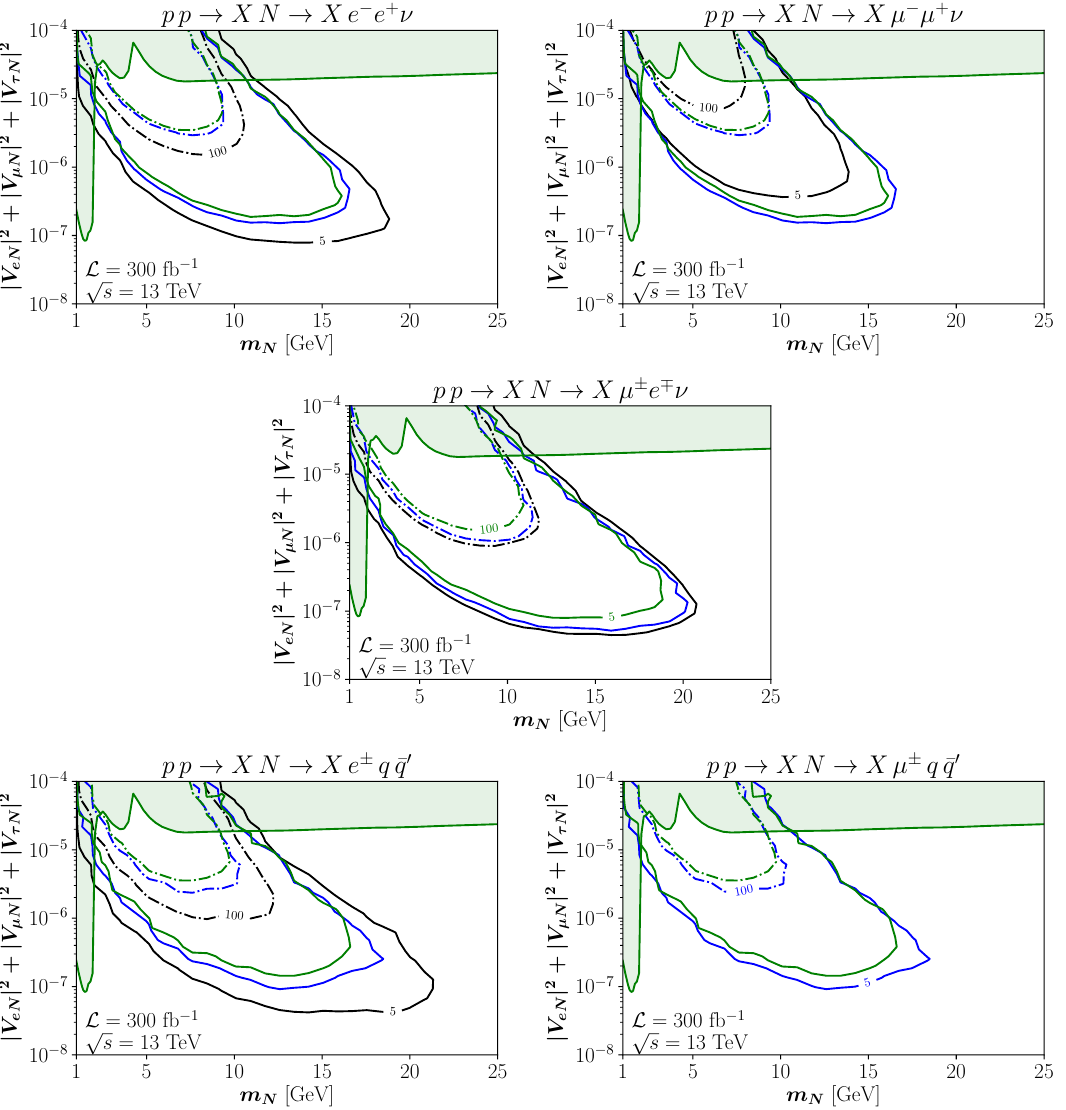
Figure 6 . Inclusive HNL production followed by its decay into di(cid:11)erent channels, for mixings 2 : 2 : 2 =1:0:0 (black), 1:1:0 (blue) and 1:1:1 (green). The solid (dot-dashed) lines V eN V (cid:22)N V (cid:28)N j j j j j j are contour lines for 5 (100) events with DV at the LHC 13 TeV with described in the text. Shaded green areas are excluded by experimental